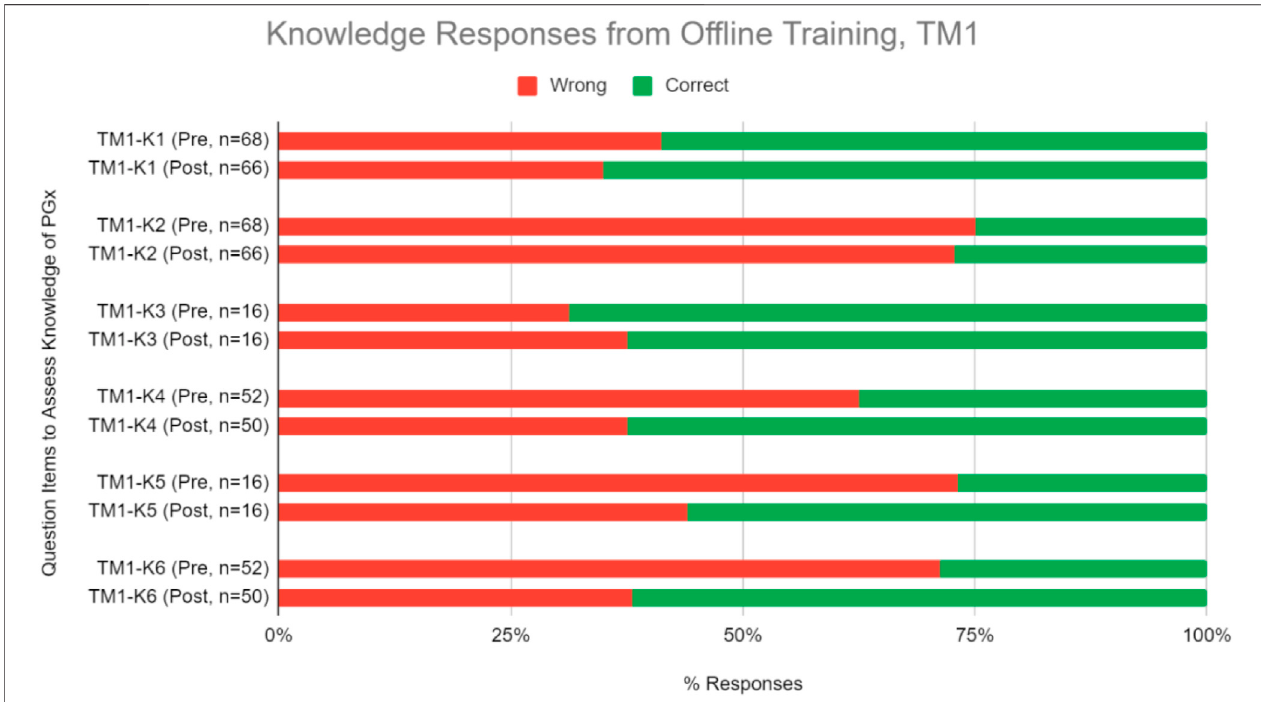
FIGURE 3 | Percent of correct or wrong responses to knowledge questions obtained during pre-and post-PGx of fl ine training TM1.